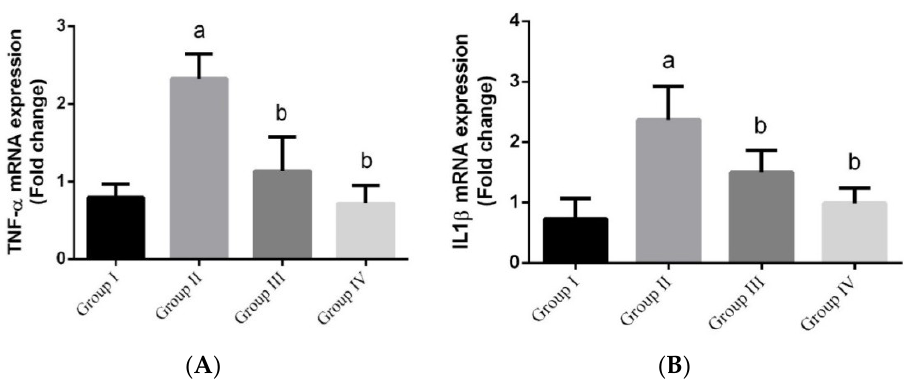
Figure 6. ( A and B ) The effect of green Ag-NPs with G. mangostana on intestinal gene expression of